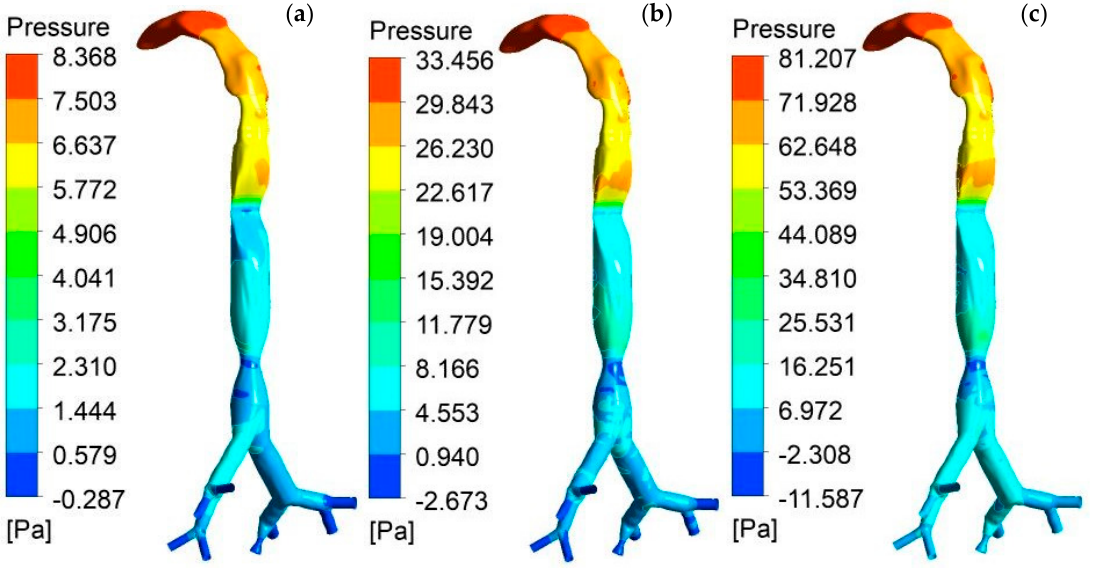
Figure 7. Pressure contours on the whole lung model for different flow rates: ( a ) 7.5 L/min; ( b ) 15 L/min; and ( c ) 25 L/min.